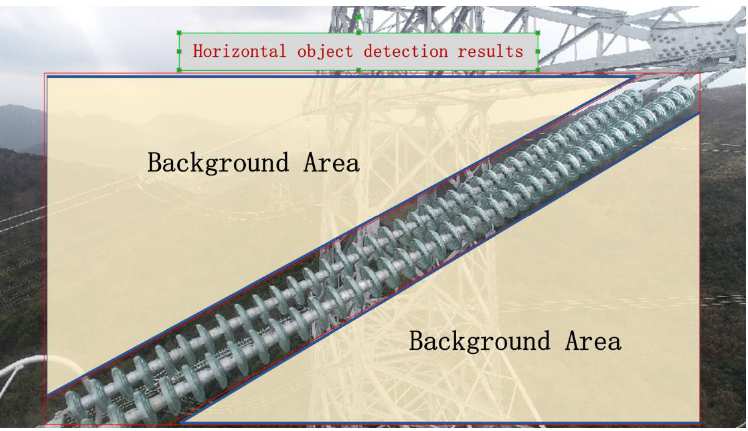
Figure 4. Horizontal object detection results.